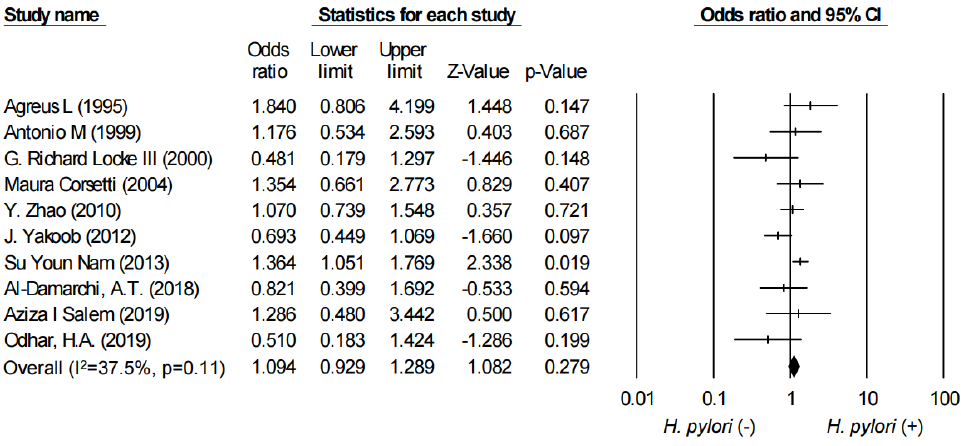
Figure 2. Forest plot evaluating the combined odds ratio (OR) between irritable bowel syndrome (IBS) and Helicobacter pylori infection.